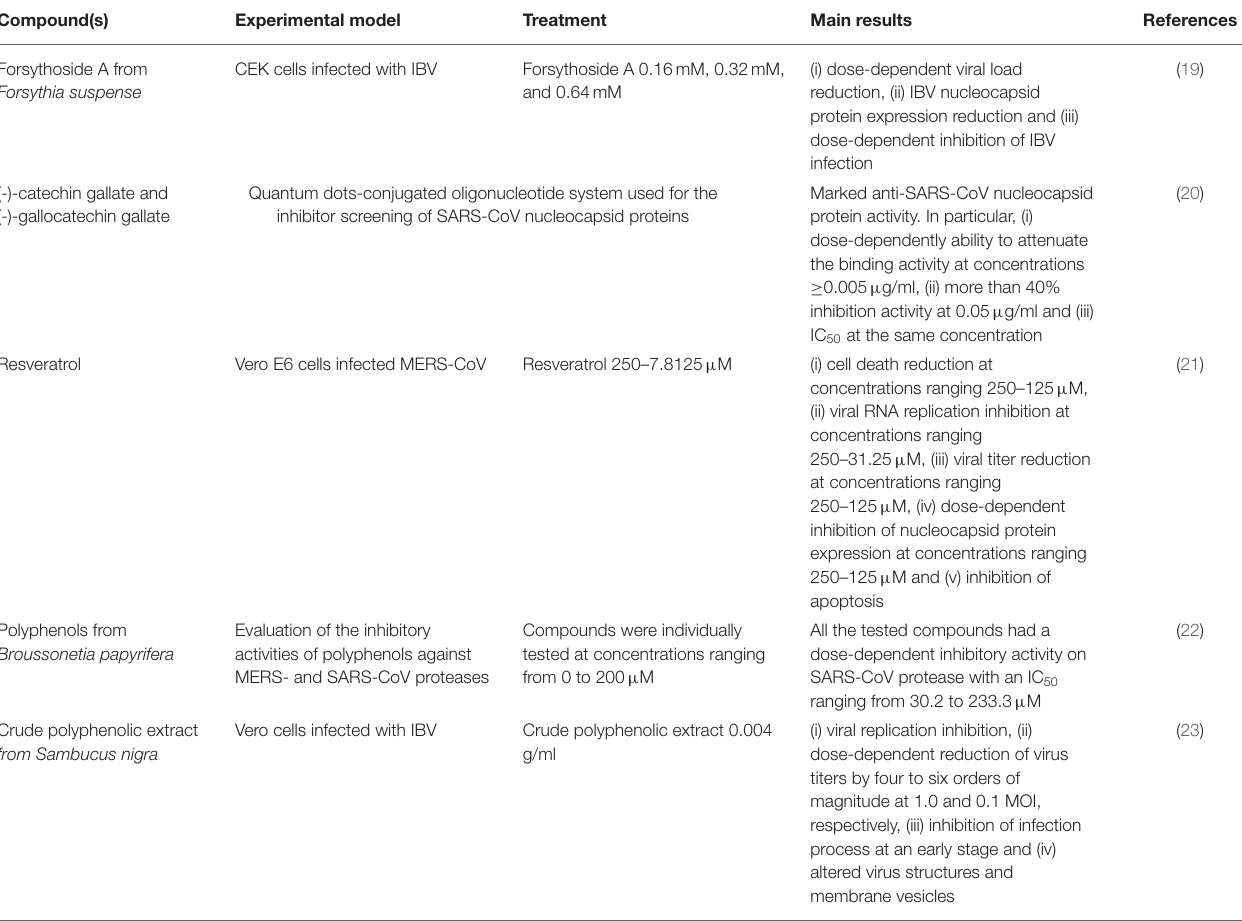
TABLE 1 | In vitro studies investigating the effects of polyphenols against coronavirus.